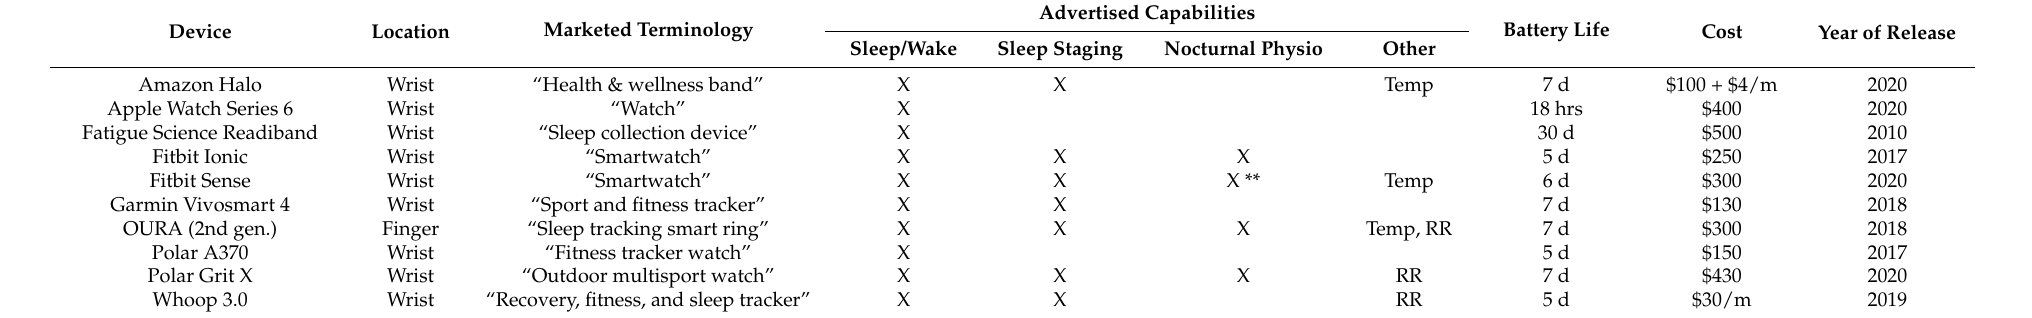
Table 2. Advertised claims and specifications of various popular devices on the market. Two asterisks (**) denotes availability with an additional paid monthly subscription. (d, days; gen, generation; hrs, hours; m, month; RR, respiration rate; Temp,